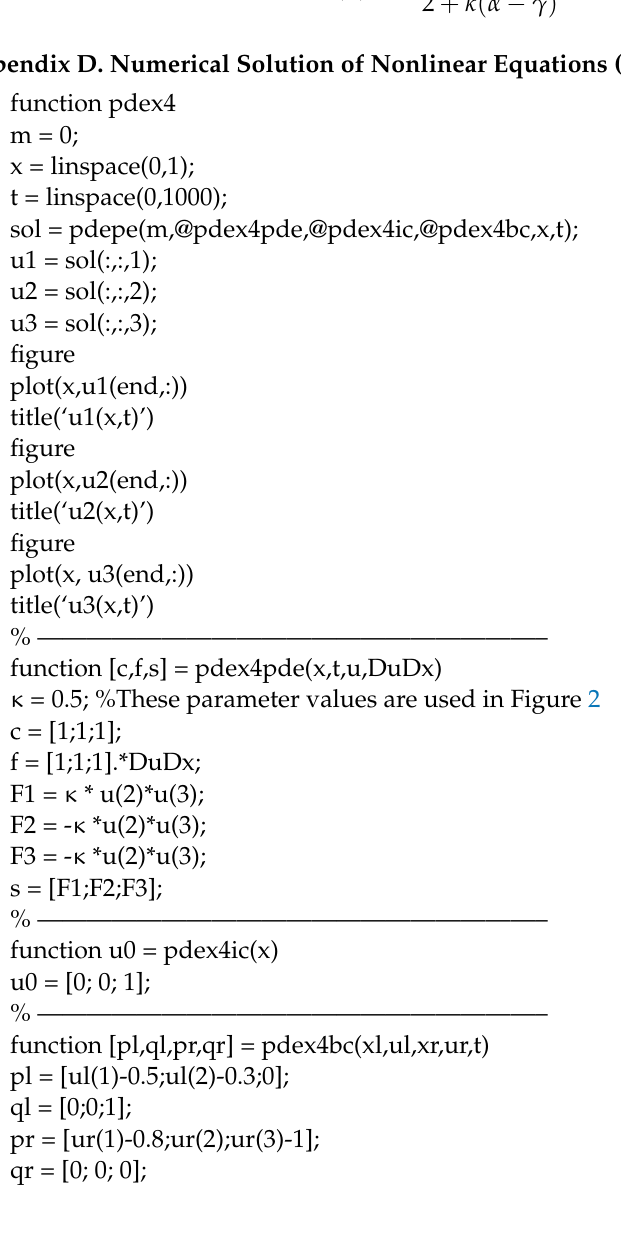
plot(x, u3(end,:)) title(‘u3(x,t)’) %